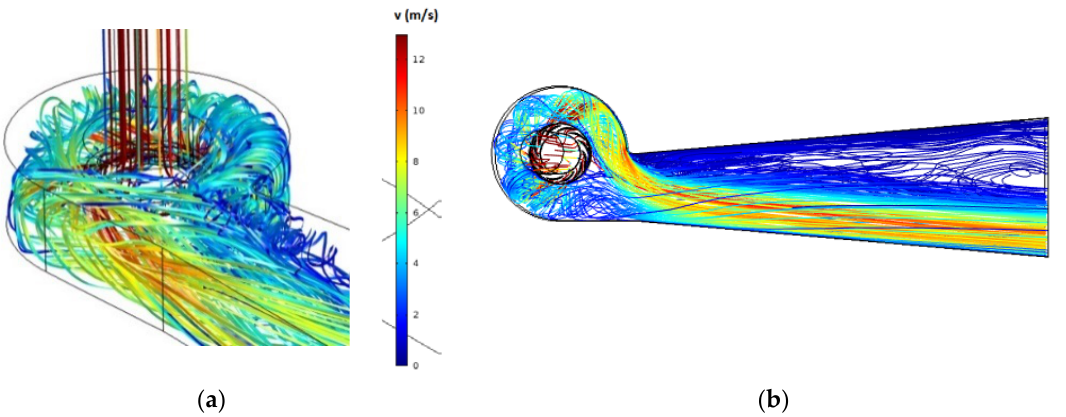
Figure 9. Detail of velocity streamlines with reference to the top view ( a ) and bottom view ( b ) of the guide vane (N = 1500 rpm).